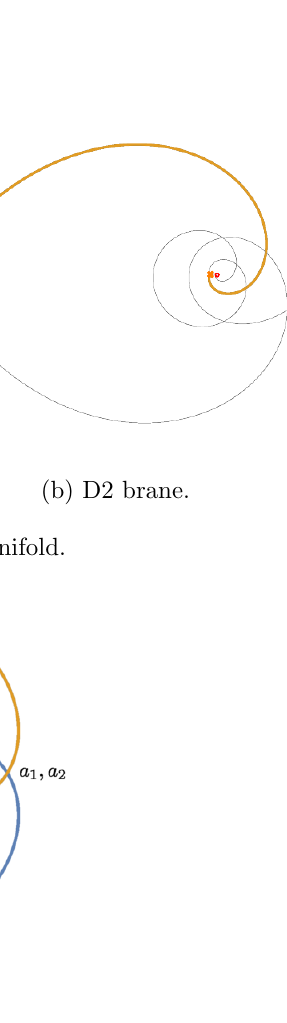
Figure 18. Superimposing the two basic (cid:12)nite webs on the conifold, showing the four bifunda- mental (cid:12)elds arising at intersection points. Note that the two basic states do not occur at the same